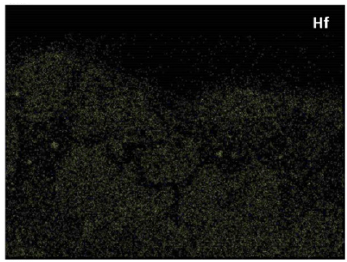
Figure 11. BSE image and X-ray elemental maps of scale formed on the alloy Nb 1.7 Si 2.4 Ti 2.4 Al 3 Hf 0.5 at 1200 °C.